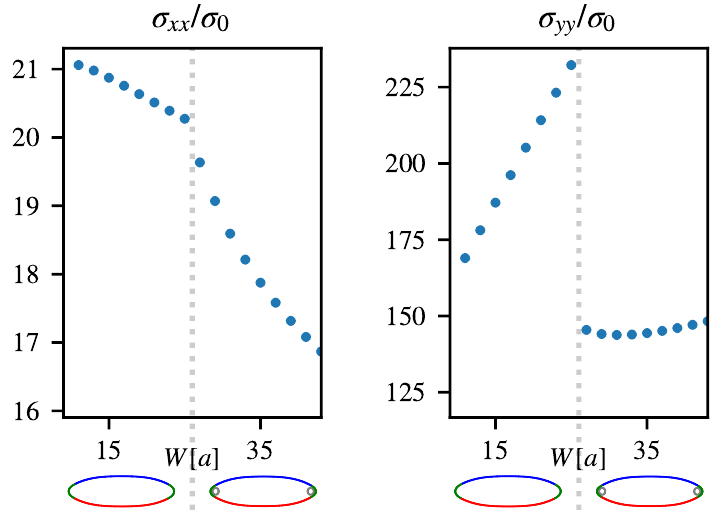
= 0.15 t , µ = 0.3 t . F b